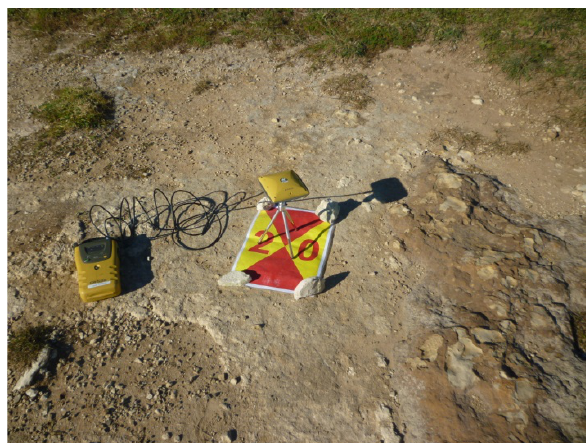
Fig 13. GPS Ground Control